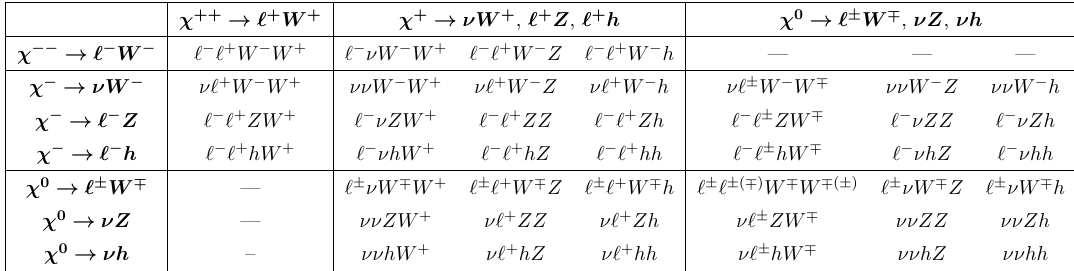
Table 5 . Decays of exotic fermions to SM particles along with the possible final state signatures of pair/associated